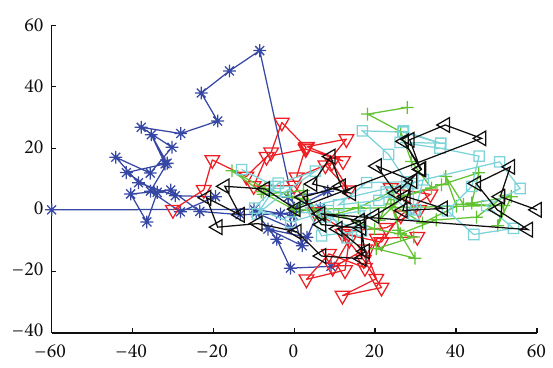
Figure 2: Synchronization errors of 𝑒 𝑖1 for the network.